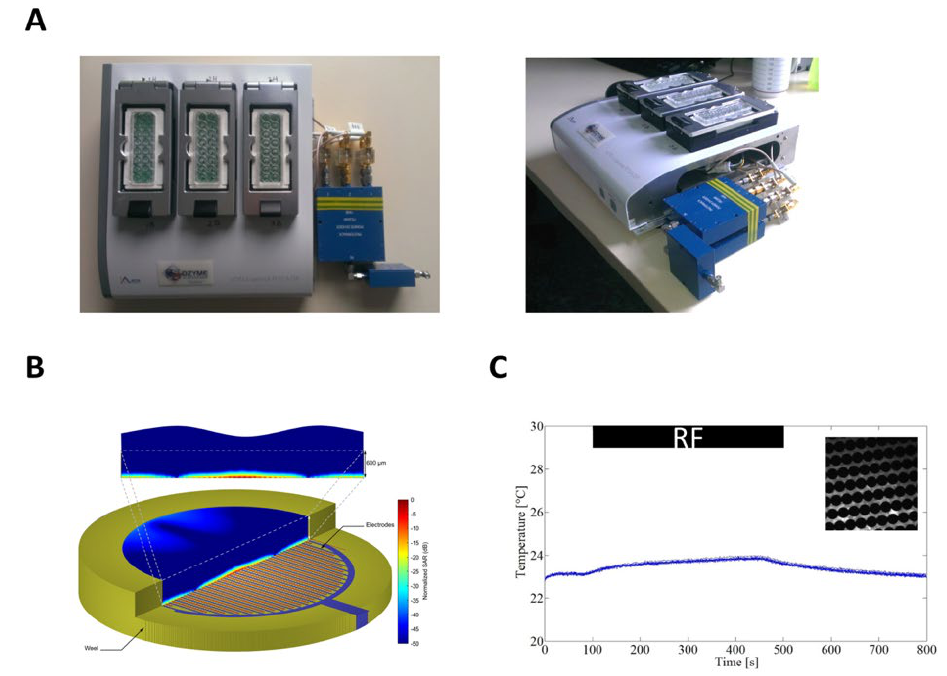
Figure 6. xCELL-RF system for simultaneous RF exposure and impedance measurements of cells. ( A ) xCELL-RF device with the RF connections to the dock. ( B ) Normalized S.A.R. distribution in the delivery system at 1800 MHz. For better readability, only half of the S.A.R. distribution and a vertical cut plane (top inset) are represented on the figure. ( C ) Experimental measurement of temperature elevation at the cell level using a S.A.R. of 240 W/kg, inset: example of picture acquired during temperature